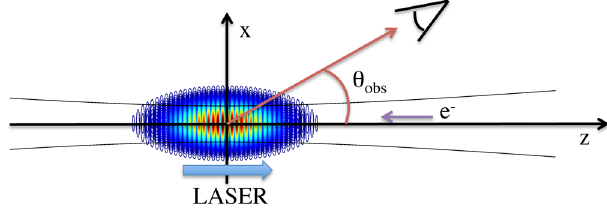
FIG. 1. Diagram illustrating the coordinate